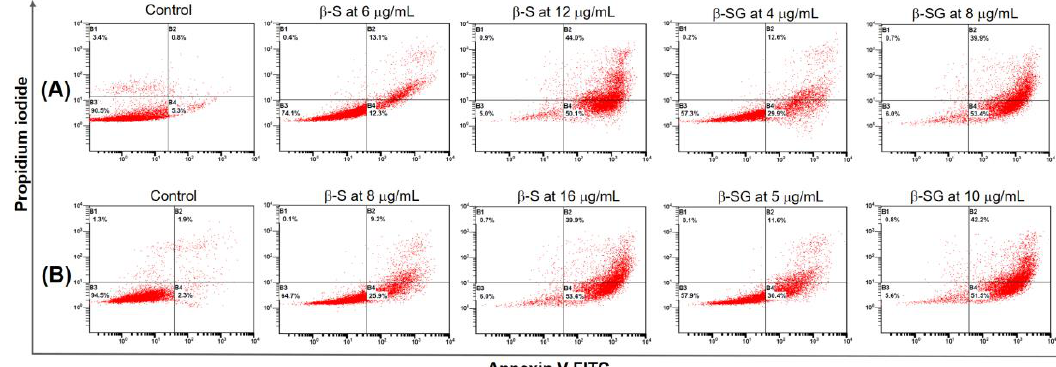
Figure 7. Quantification of apoptosis induced by β-S and β-SG in HepG2 ( A ) and Huh7 ( B ) cells evaluated using Annexin V-FITC/PI dual staining for 48 h and analyzed using fluorescence-activated cell sorting.